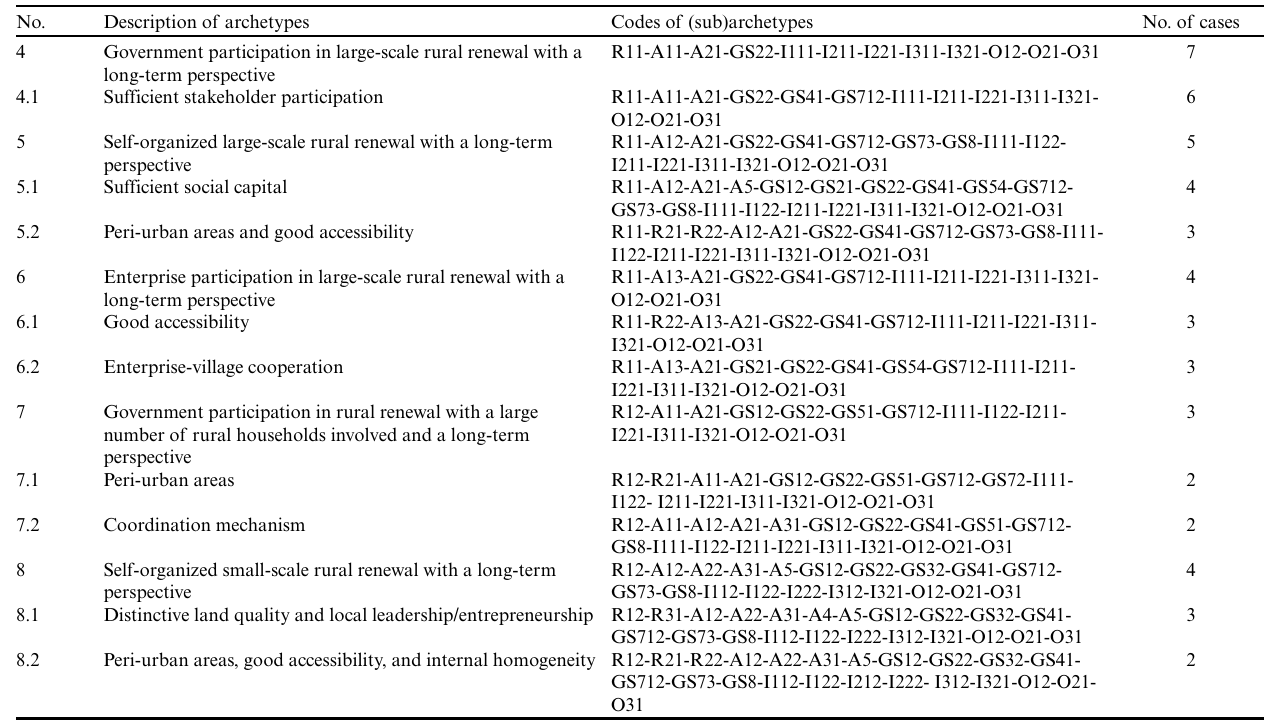
Table 4 . Archetypes for sustainable rural